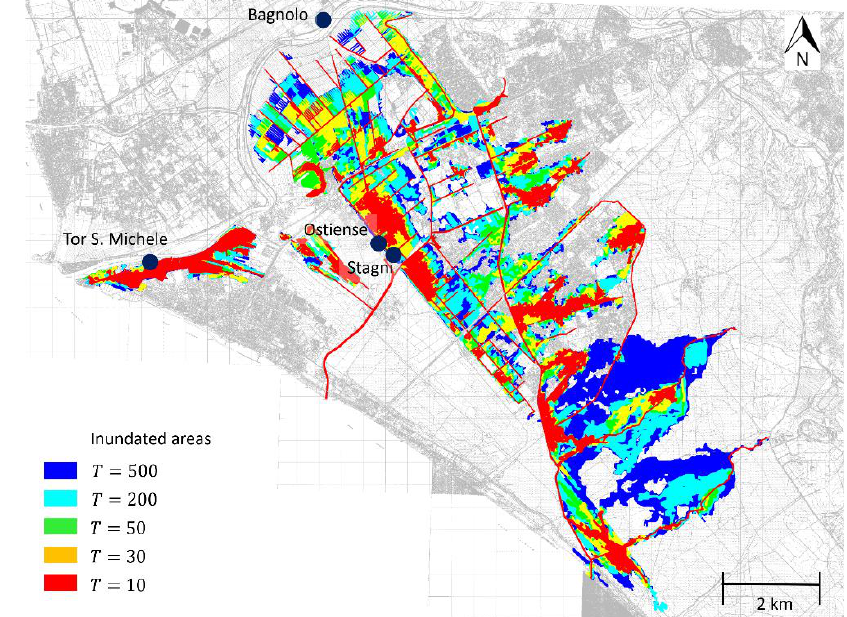
Figure 10. Inundated areas as function of the return period T . The map includes the inundated areas evaluated in a previous study [24] (shaded area of Figure 1).